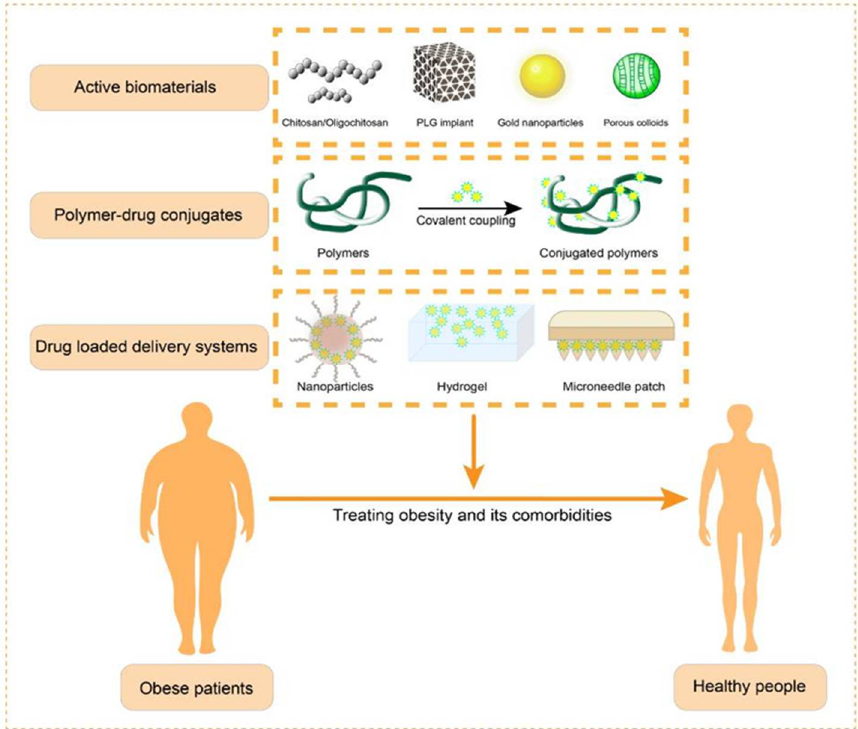
Figure 2. Main strategies for the application of biomaterials to combat obesity and its comorbidities.